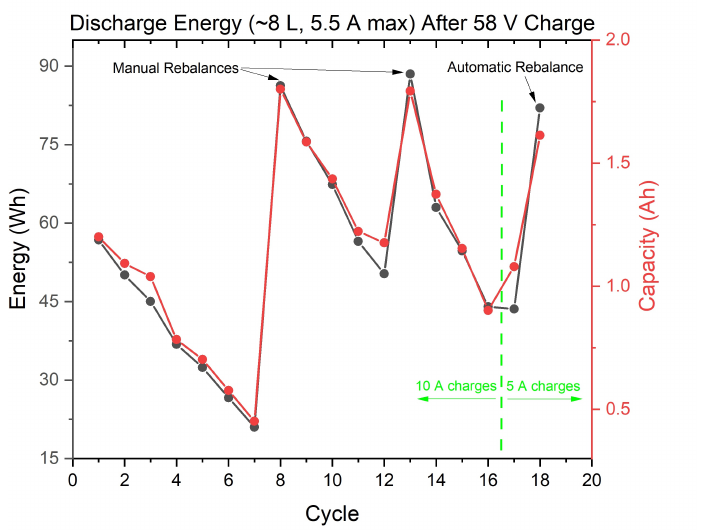
Figure 3. Effect of rebalancing mechanism on the discharge performance (5.5 A max) of 8 L of electrolyte